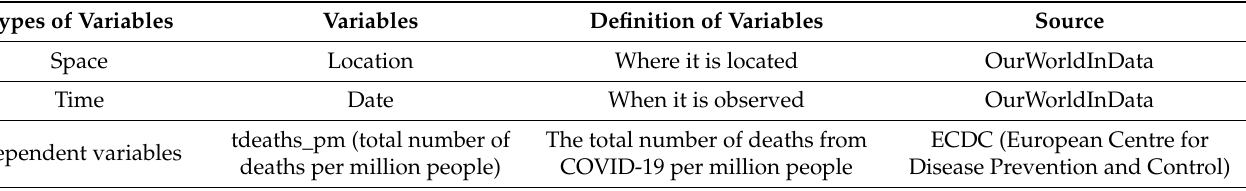
Table 1. Summary of variable.